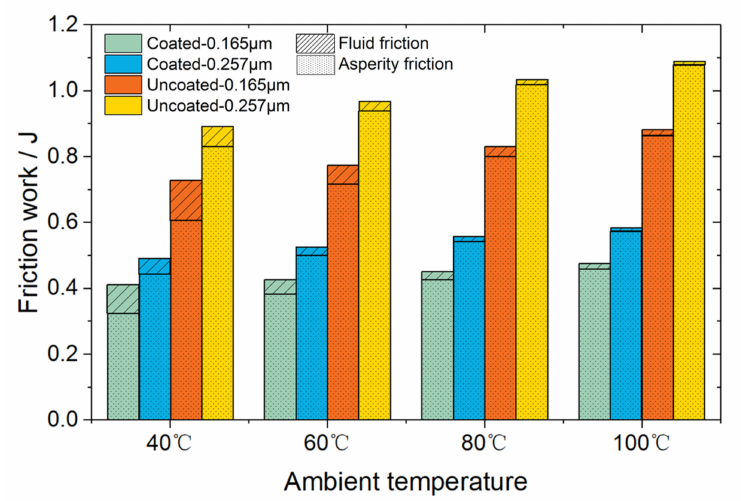
Figure 9. The friction work for di ff erent surface conditions at various ambient temperatures in a cam cycle under the normal